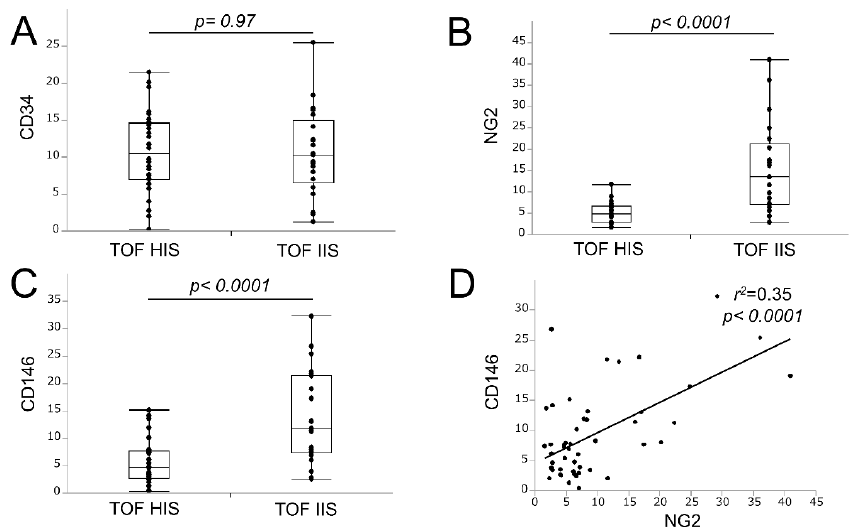
Figure 2. Relationship between TOF-MRA signal intensity and the number of neovessels. The di ff erence in the number of CD34-positive neovessels according to TOF-MRA signal intensity is not significant. The p -value is based on the Student’s t-test ( A ). The numbers of NG2-positive ( B ) and CD146-positive ( C ) neovessels are significantly lower in the TOF-HIS group than in the TOF-IIS group. P -values are based on the Student’s t-test. The correlation between the numbers of NG2 and of CD146-positive neovessels is significant. Spearman’s rank correlation test was used to assess correlations ( D